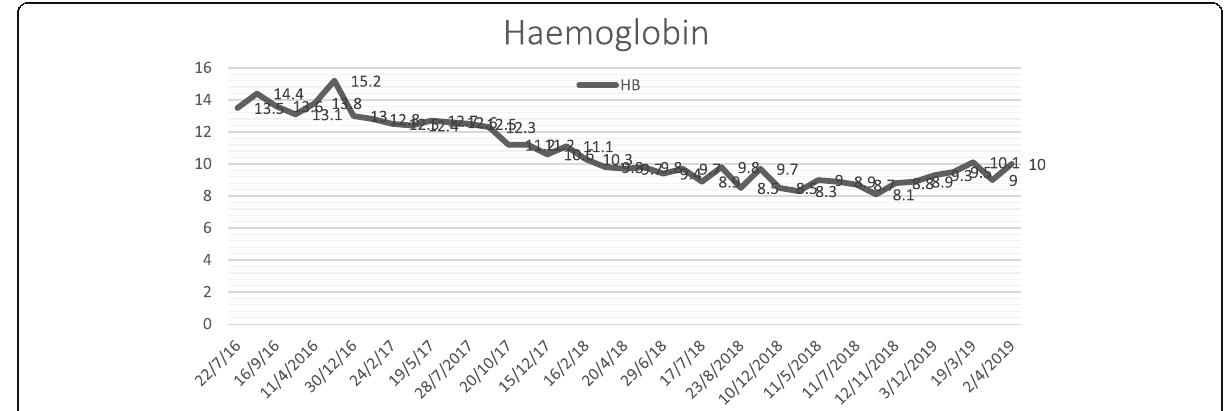
Fig. 1 Haemoglobin levels on Natalizumab which was stopped on